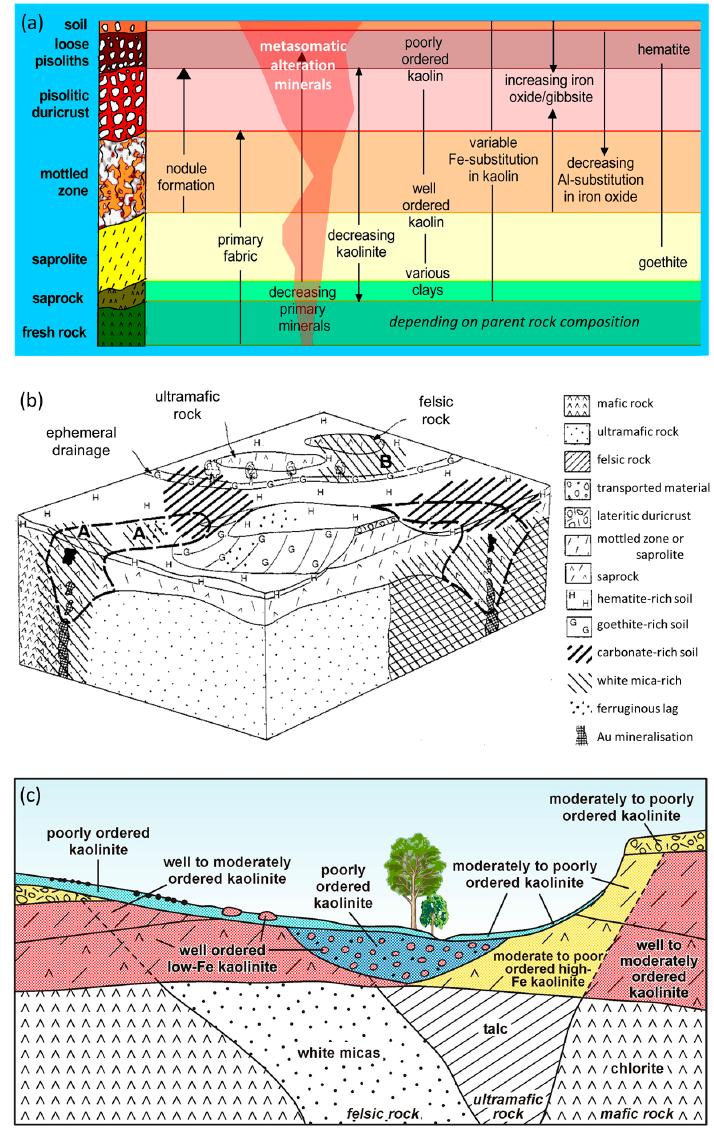
Figure 1. Schematic mineral-regolith models. ( a ) Cross section of a lateritic profile showing changes in a range of fresh rock and weathering minerals, including a zone of metasomatic alteration that persists from fresh rock through to the surface [44]; ( b ) Block diagram that includes different types of parent rock as well as erosional dissection through the lateritic profile. Areas of white mica in weathered mafic or ultramafic rocks (“A”) are spectral-sensing exploration targets [44]; ( c ) Dissected lateritic profile over different parent rock types showing diagnostic variations in kaolin physicochemistry